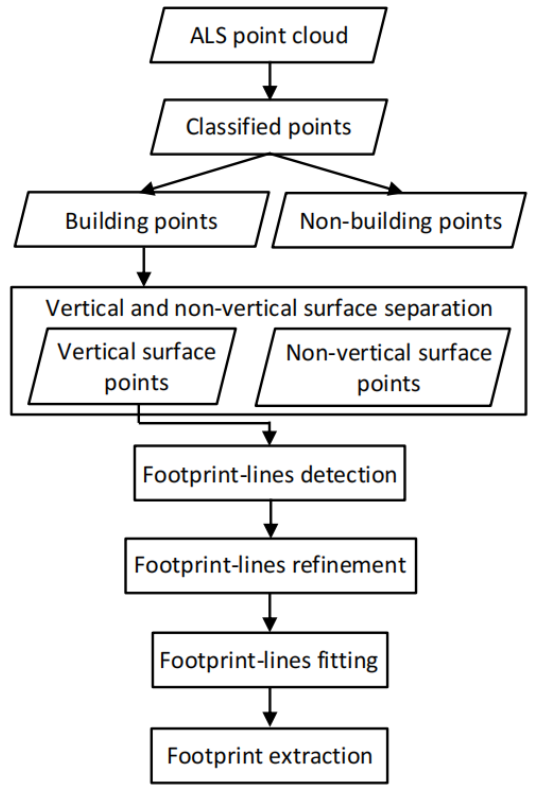
Figure 1. Flowchart of the proposed